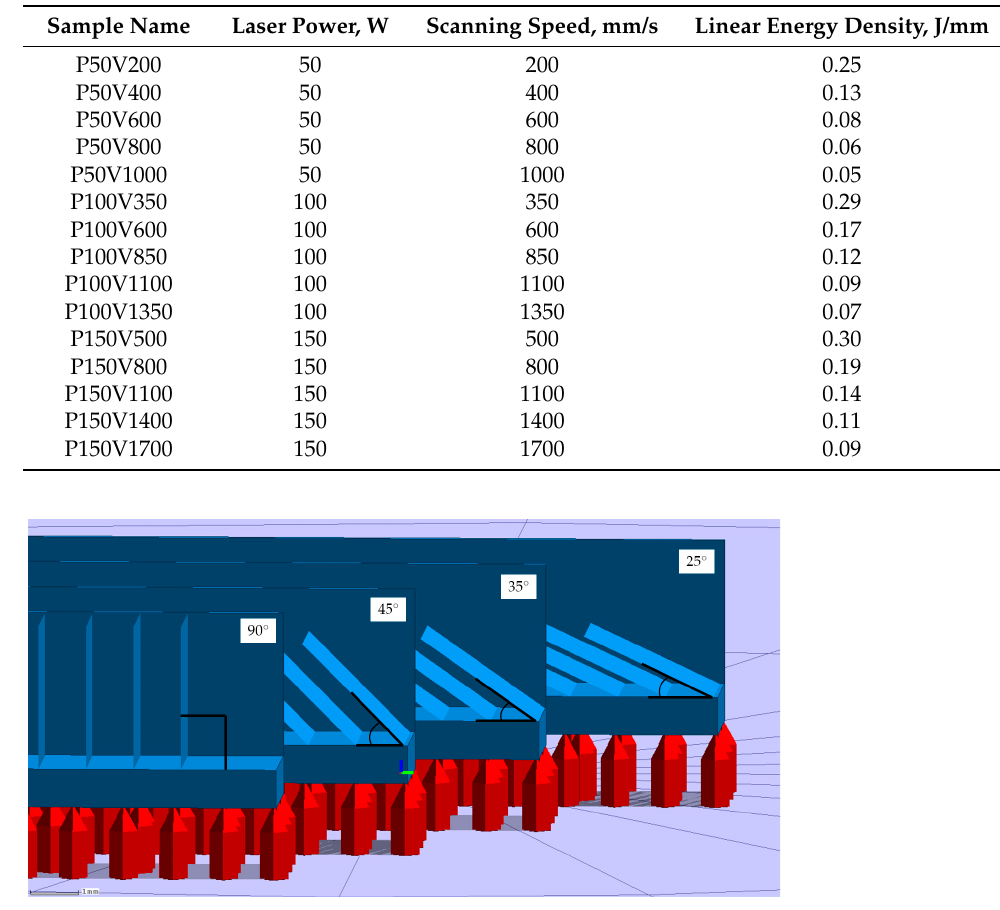
Table 1. The window of process parameters used for the optimization procedure.